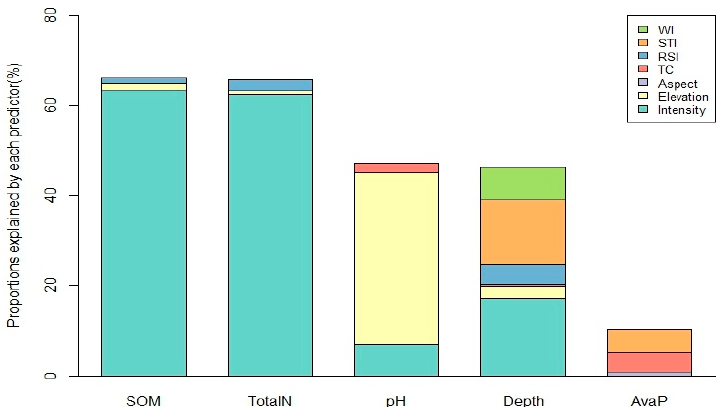
Figure 2. The proportion of variance explained by each selected variable in the optimal scale. The selected variables for SOM, Total N, and pH have the same scale, which is 1.5 m grid resolution and 4.5 m neighbor extent; the scale of the selected variables for Depth is 50 m grid resolution and 250 m neighbor extent; and the scale of the selected variables for Depth is 10 m grid resolution and 70 m neighbor extent.